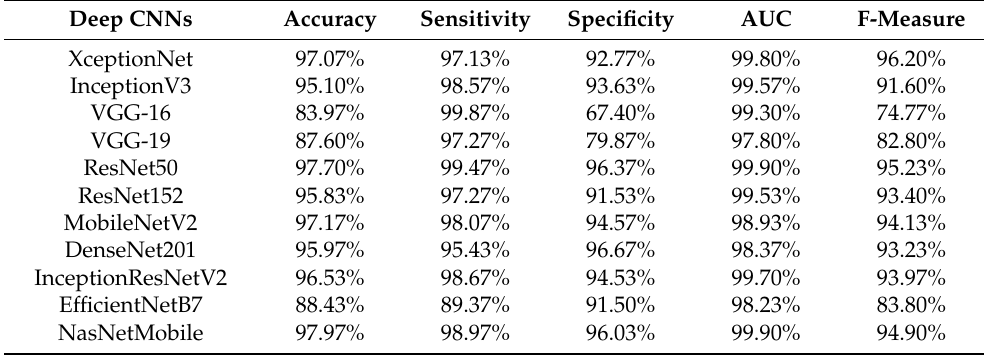
Table 3. Classification results of normal, pneumonia, and COVID-19 on the whole CXRs using 11 CNNs (Approach 0 without lung segmentation: Unbalanced dataset).